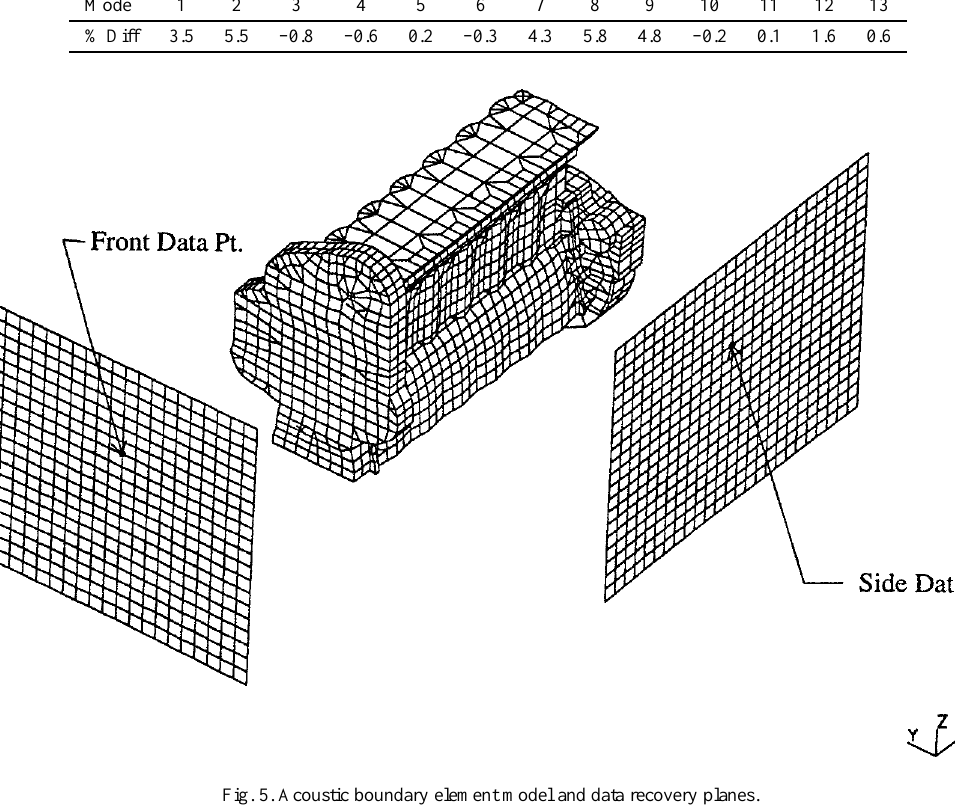
Fig. 5. Acoustic boundary element model and data recovery planes.